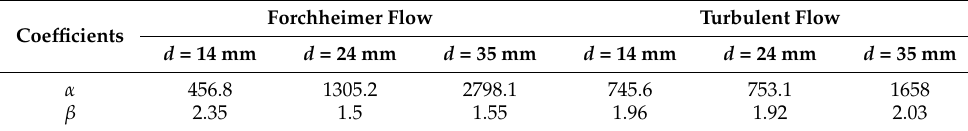
Table 2. Values of the modified coefficients α and β for different flow